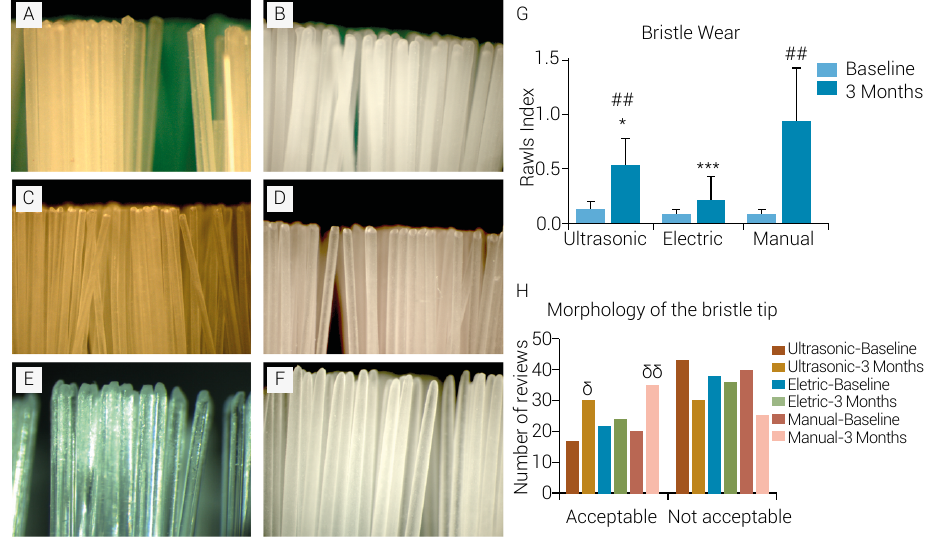
Figure 6. Figures A-F show the representative images of the tip of the bristles of the different types of toothbrushes used in this study. The images A, C, and E represent the conditions of the tip of the bristles of the US, E and M toothbrushes before the use, respectively. The images B, D and F represent the conditions of the tip of the bristles of the US, E and M toothbrushes after 3 months of use, respectively. Representative graphs of the G) bristle wear index and H) morphology of bristle tips index. The M group presented more worn bristles than the US and E groups after the 3 months of use. *p<0.05; ***p<0.001- Less bristle wear than the M group at 3 months-Kruskall-Wallis complemented by Dunn ##p<0.01-More bristle wear than the baseline period-Wilcoxon; δp<0.05; δδp<0.01- Morphological pattern more acceptable than the baseline period- Chi-square